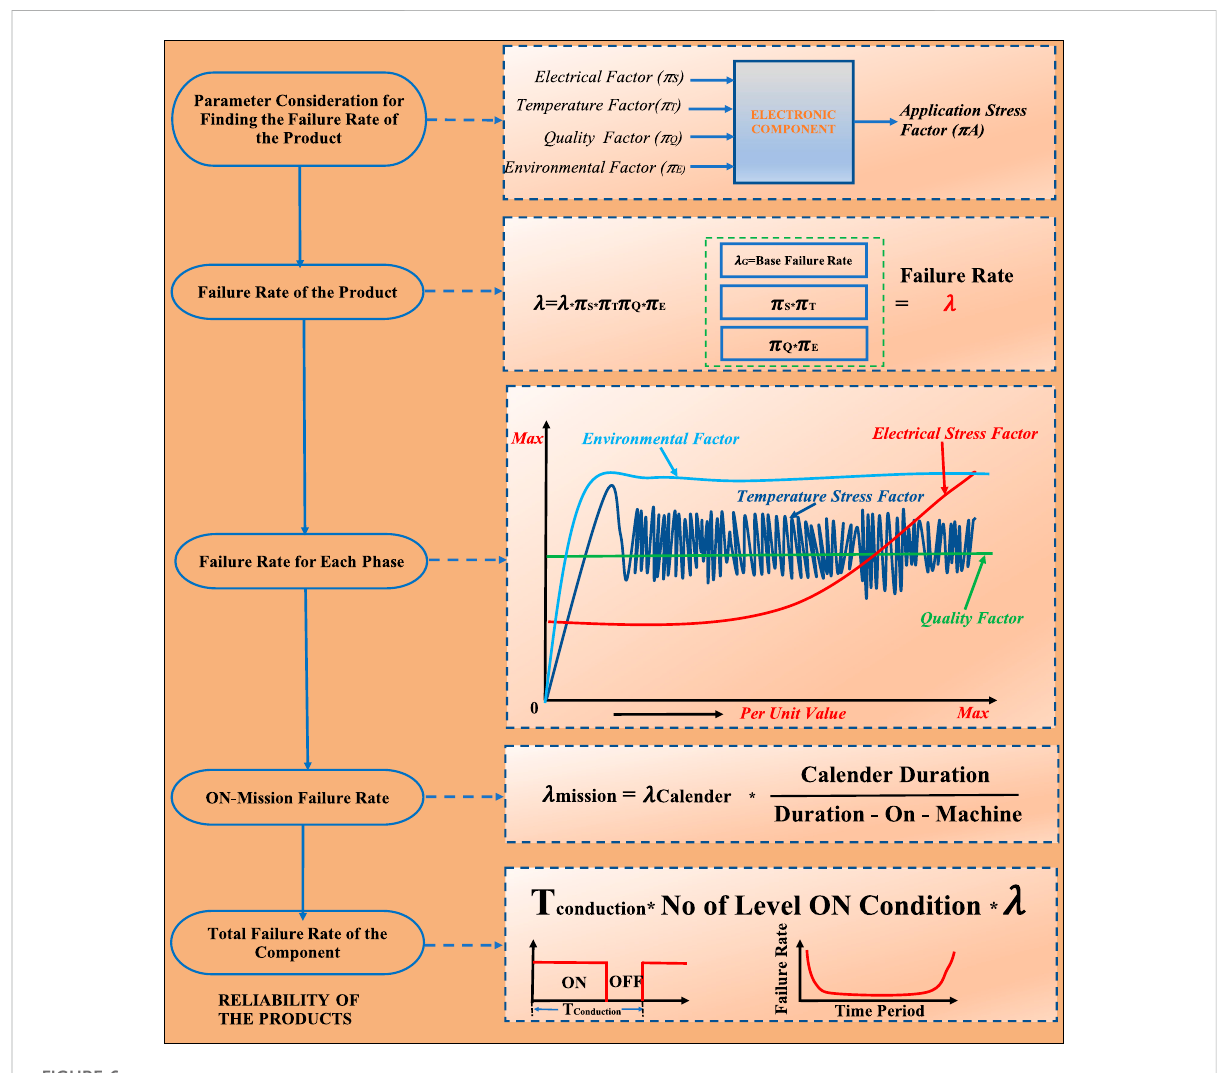
FIGURE 6 Failure rate calculation fl